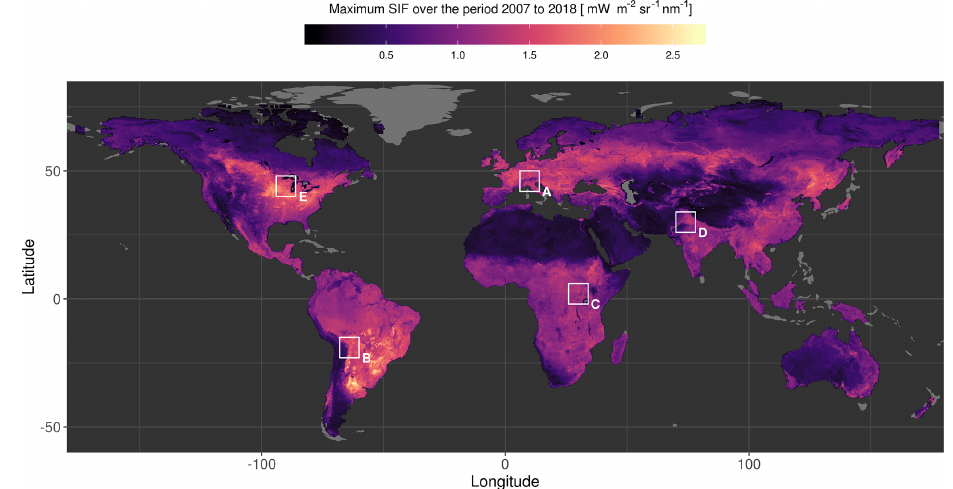
Figure 5. Maximum value of SIF over the entire new PK downscaled product. Values are in megawatts per square metre per steradian per nanometre (mWm − 2 sr − 1 nm − 1 ), the spatial resolution is 0.05 ◦ and the temporal range spans from early 2007 to the end of 2018. The white boxes represent the zones illustrated in Fig.